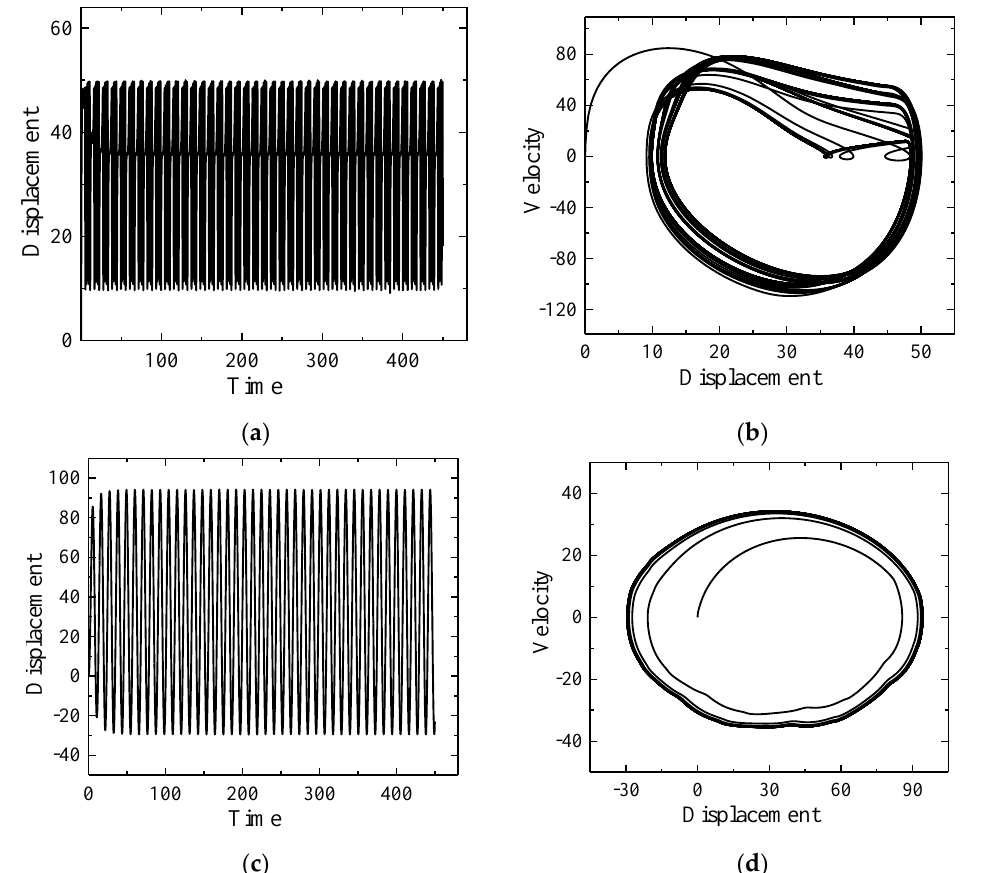
Figure 17. Evolutions of the displacement and speed-displacement diagram of brake disc and brake shoe at the normal braking load of 120 N. ( a ) Evolution of the displacement of the brake shoe. ( b ) Evolution of the speed-displacement diagram of the brake shoe. ( c ) Evolution of the displacement of the brake disc. ( d ) Evolution of the speed-displacement diagram of the brake disc.